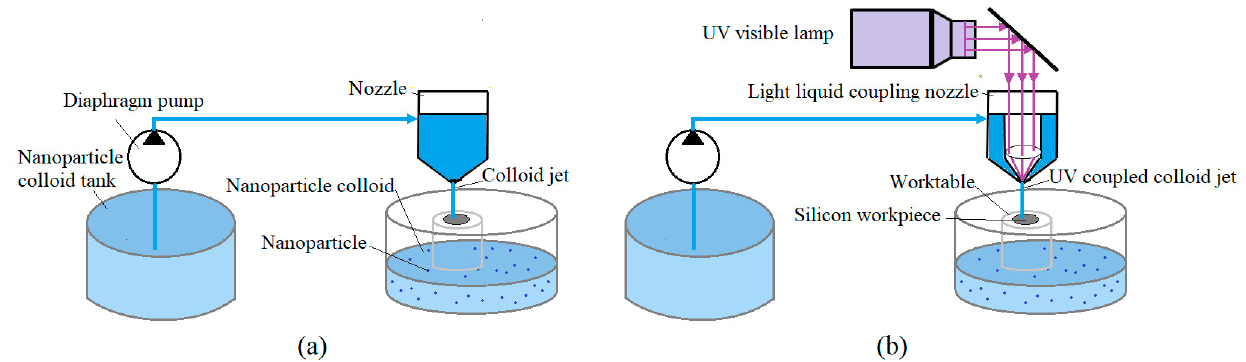
Materials 2021 , 14 , 1070